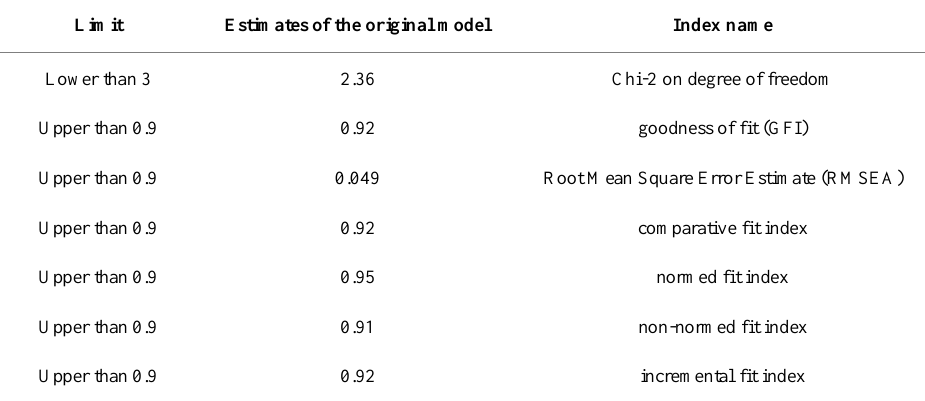
Table 1. Interpretation of structural equation model.